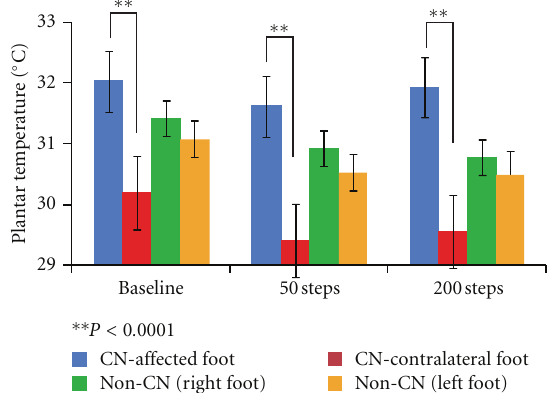
Figure 2: Plantar temperature in hot spot recognized in the mid- foot region.